Question: What does this figure show? Answer in one sentence.
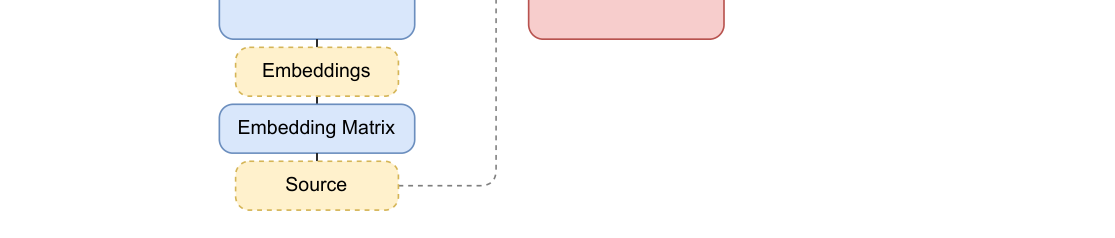
Answer: The proxy setup: Preemptively obtain an approximate score for the system performance through the encoder, circumventing the autoregressive decoding. The score can be differentiated with respect to encoder outputs in order to augment the system behaviour.